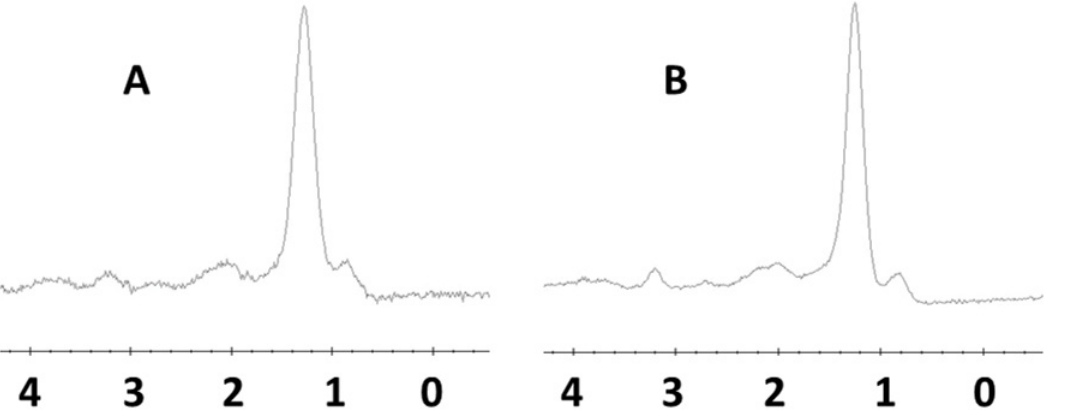
Fig 2. PRESS-localized single voxel 1H MR spectrum originating from liver parenchyma of the same ROI using body coil (a) and phased array coil (b); SNR: (b) was better than (a), so the score was marked 1.